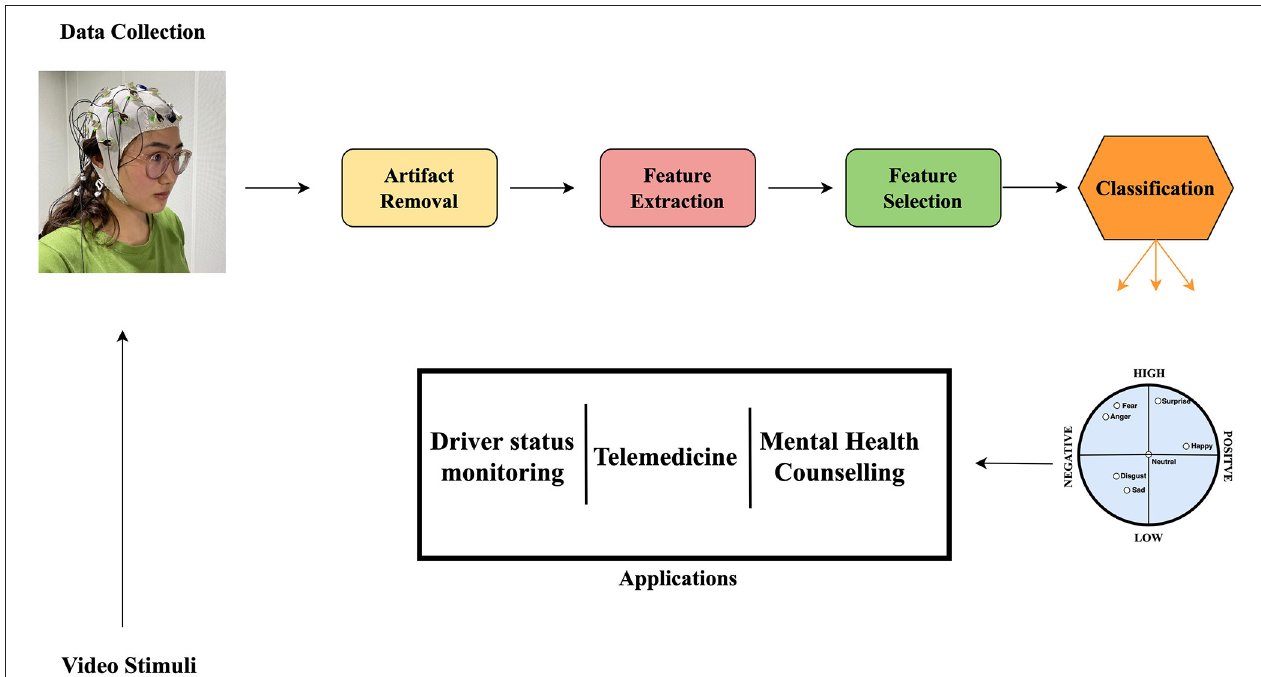
FIGURE 1 | Illustration of an affective brain-computer interfaces (aBCI) and its applications (Fordson et al., 2021). Source for the photo top left: Center for Human Body Data Science, School of Electronic and Information Engineering, South China University of